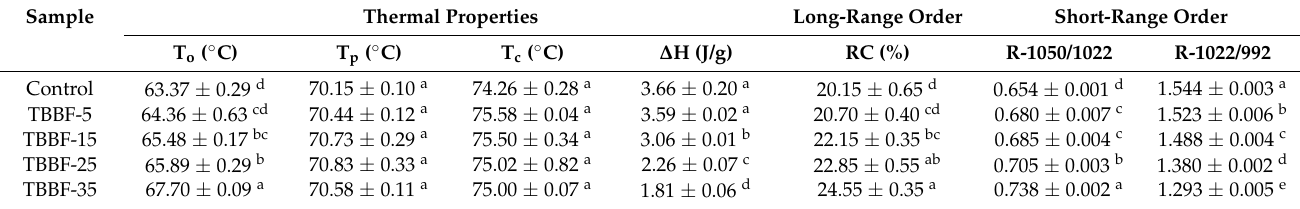
Table 5. Effect of TBBF substitution on the thermal properties, and long- and short-range ordered structures of starch in